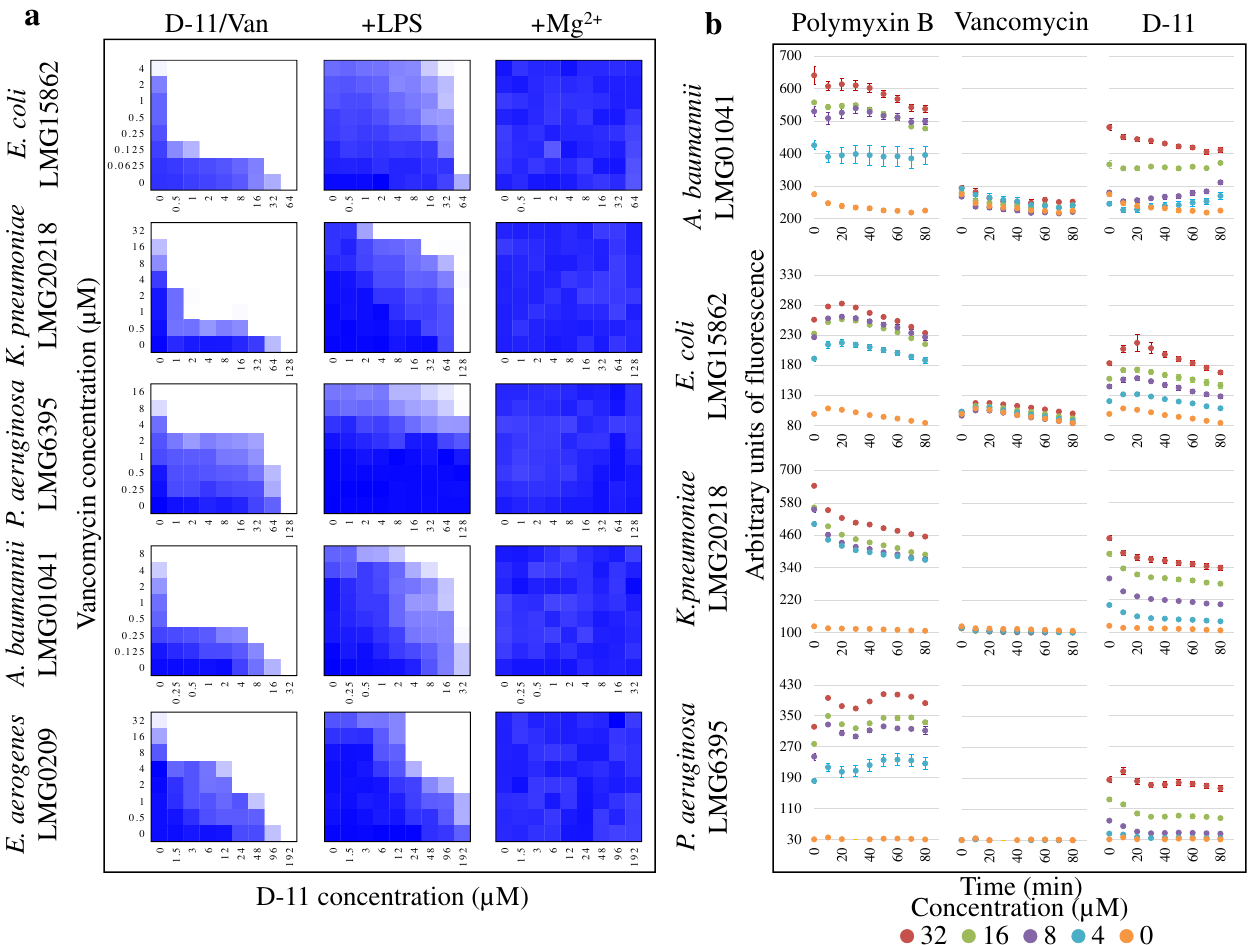
Fig. 2 Effect of LPS in the D-11/vancomycin synergism and outer-membrane permeabilization assay. a Checkerboard broth microdilution assay diagram showing the effect of LPS and Mg 2 + in the D-11/vancomycin synergistic relation. Dark region represents higher cell density. b Dose-dependent outer- membrane permeabilization by D-11 against different Gram-negative bacteria. Polymyxin B was used as a positive control and vancomycin as